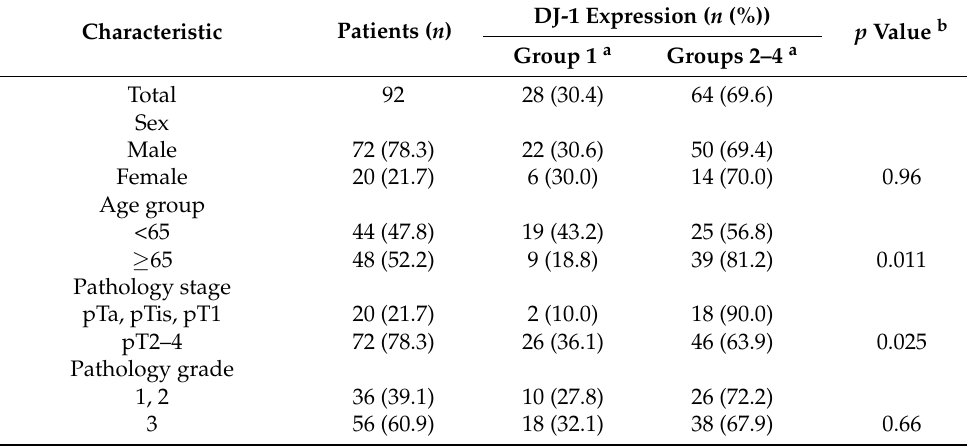
Table 2. Association of DJ-1 expression with the clinicopathologic characteristics of patients who underwent radical cystectomy for bladder